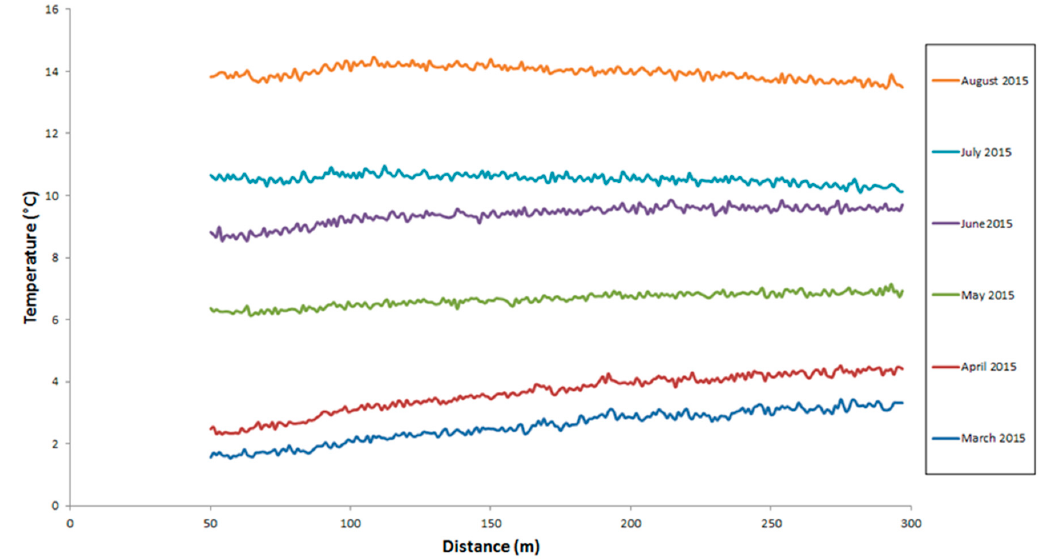
Figure 10. Seabed sediment temperatures measured from March 2015 to August 2015 in Liito- oravankatu. Heat loading is observed as increased temperatures in the sediment layer.